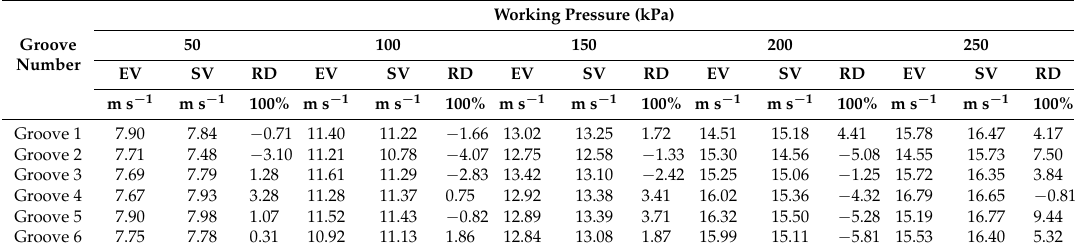
Table 2. Initial trajectory velocity (m/s) with various numbers of grooves corresponding to a 4.98-mm nozzle at different working